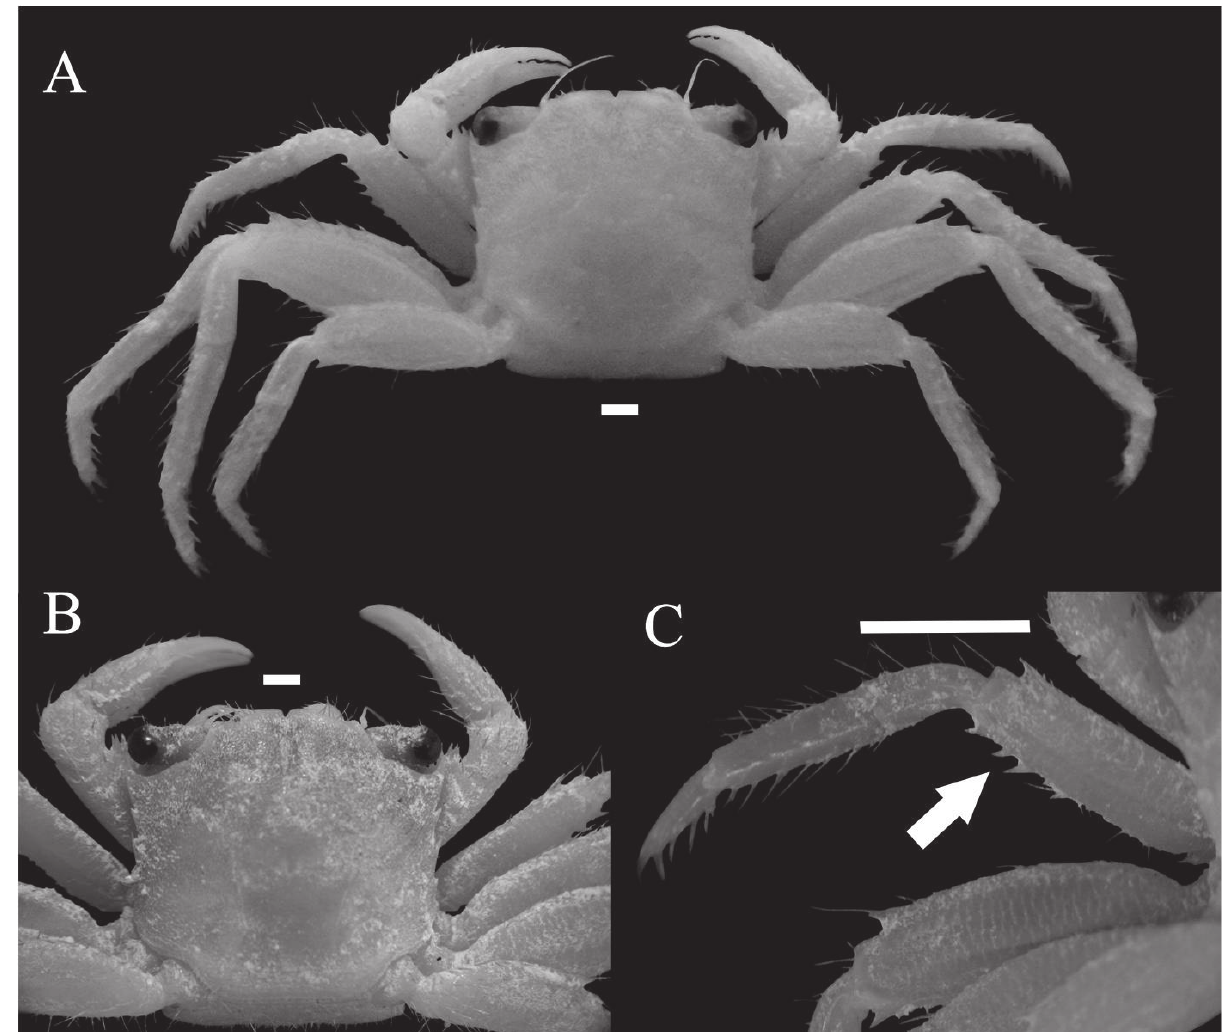
Figure 1. Euchirograpsus americanus A. Milne-Edwards, 1880, ovigerous female from northeastern Brazil (Potiguar Basin, MT-52- 2; MOUFPE 15697). (A), Habitus, dorsal view; (B) carapace, dorsal view; (C) second pair of pereopods (P2), merus indicated by arrow. Scale bar = 1